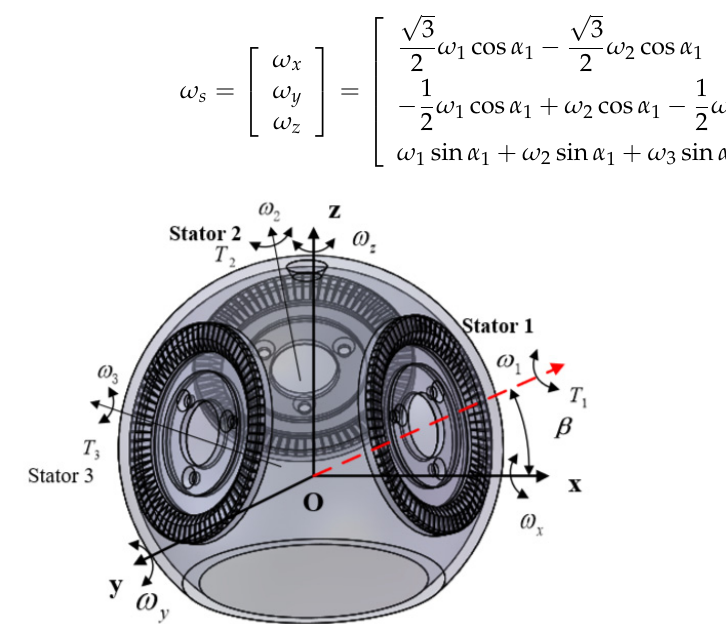
Figure 2. Schematic diagram of piezoelectric ceramic sheet.